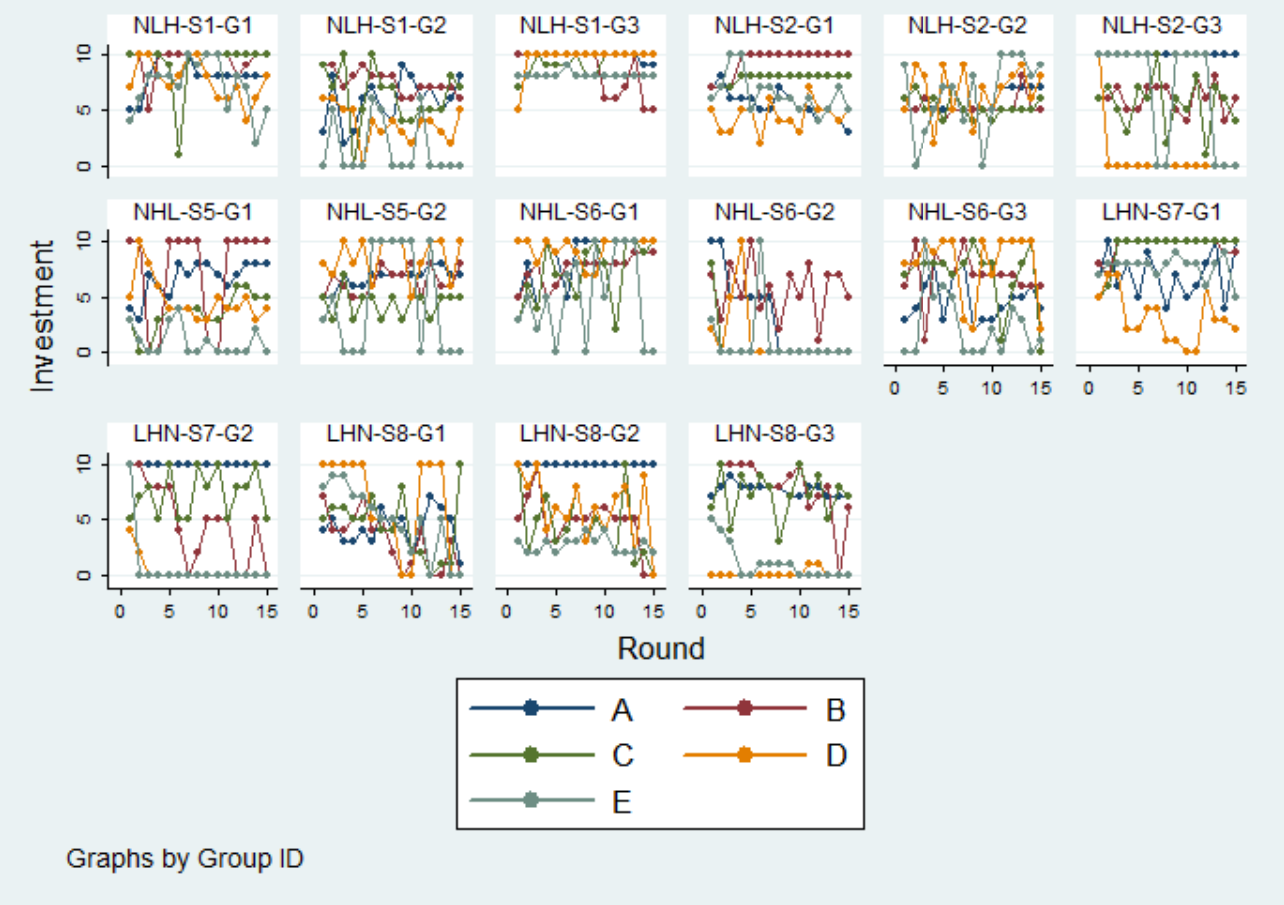
Figure S1: Investment per group per position. Each group is preceded by the treatment label (NLH = no, low and high Variability, NHL = no, high and low Variability; LHN = low, high and no